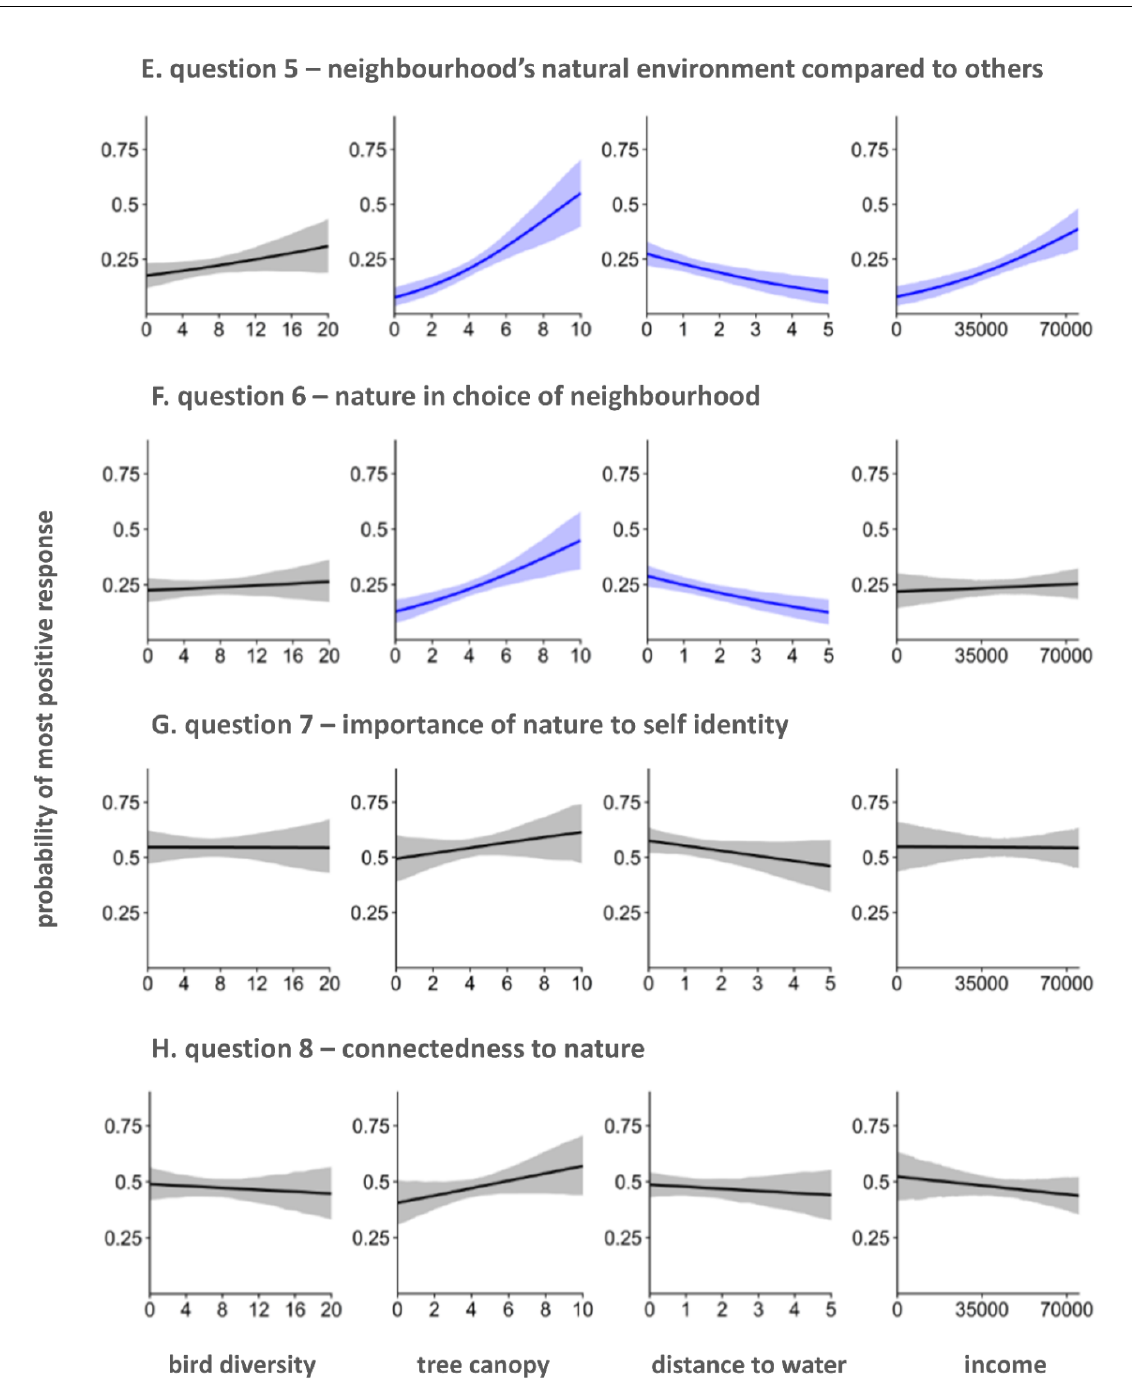
Figure 2. The independent effects of each of the four predictor variables, after controlling for the effects of all other variables, on the probability (+/ − 95% credible intervals) of a participant answering the most positive option to each of questions 1 to 8 in Table 1 (rows A to H ). Predictor variables are bird species richness, tree canopy cover in ha within the 250-m radius area surrounding the residence, distance of the residence to the nearest water body in km, and median income of the Canadian Census Dissemination Area within which the residence was found. Each plot shows the effect of one predictor, while all other predictors are held constant at their means. Effects plotted in blue have 95% credible intervals around the coefficient estimates not overlapping 0.